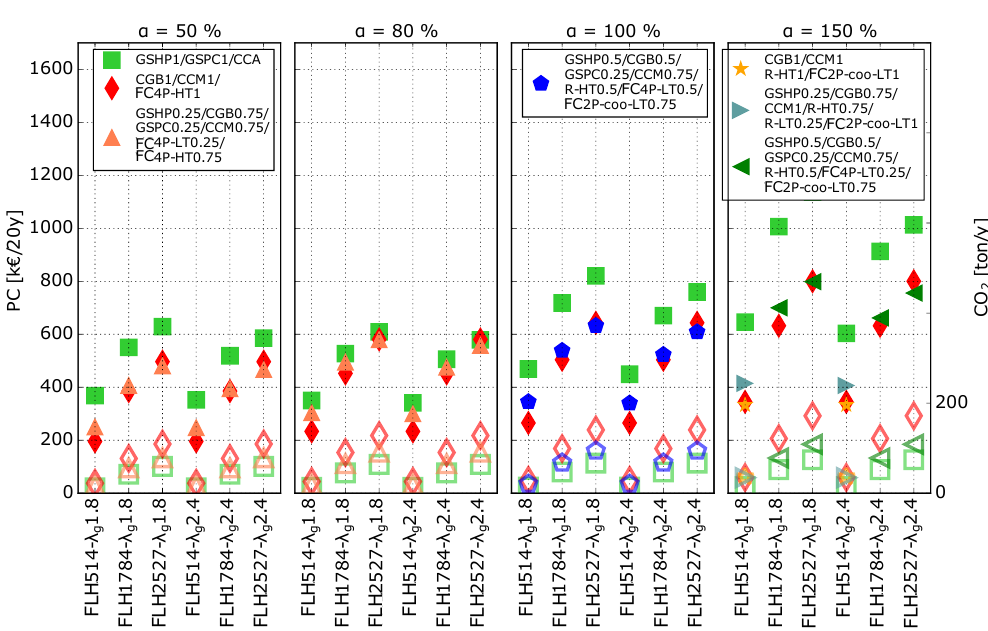
Figure 9. Present Cost (PC , filled markers) and CO 2 emissions (unfilled markers) of HVAC scenarios ( Geo-Sce ) containing maximum two heat and two cold production systems, each coupled to its own emission system for the different parameter values of Table 4 but P h,max = 150 kW, P spe = 27 W/m 2 and the LDC are of logarithmic shape. Only the GEOTABS ( GEOTABS-M-Sce ), the most conventional ( Conv-M-Sce ), the cheapest ( M-Sce *) and the cheapest geothermal scenarios ( Geo-Sce *) are plotted. The legend specifies the components of the HVAC scenario and the fraction of installed power they